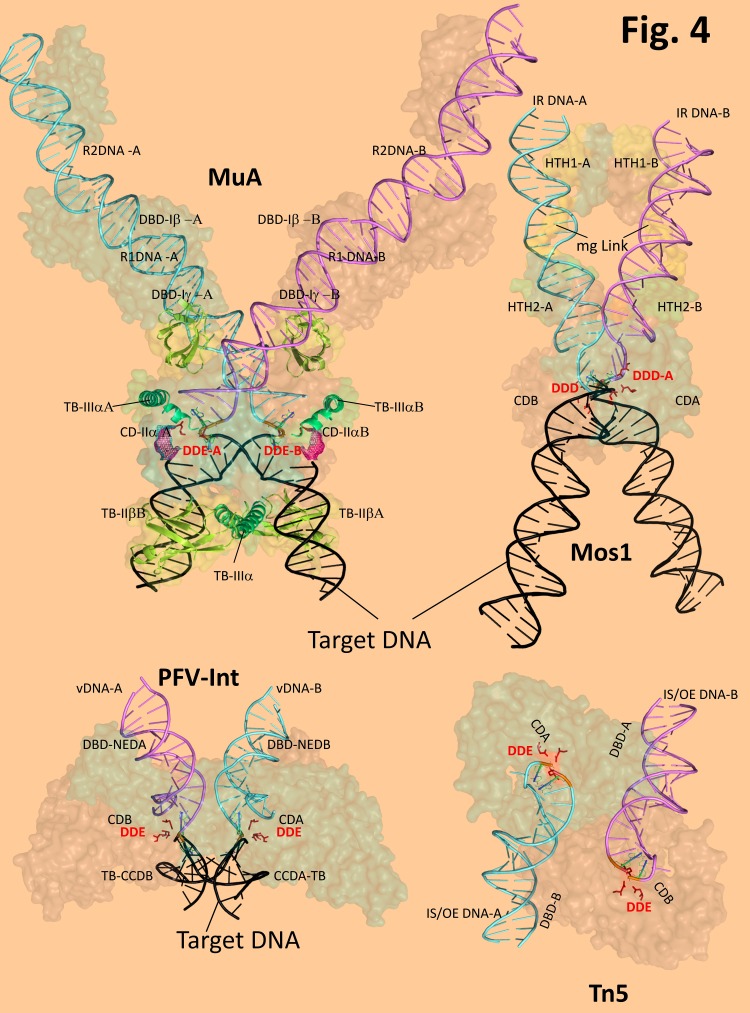
Diagram depicting 3D structuresof MuA transpososome16(PDB code - 4CFY.pdb), Mos1PEC18 (PDB code - 3HOT.pdb), PFV-Intasome15 (PDB code - 3OS0.pdb) and of the Tn5 synaptosome14(PDB code - 1MUS.pdb), showing in color the positions of: the IS/IR DNA terminal sequences, DBD-DNA binding domains, CD-catalytic domains, DDE/D catalytic triad motif. in red, 3'OH and transferred DNA strand in orange, TB-target nonspecific DNA binding sites, with respect to each functional dual subunit (AB) organization of each complex.